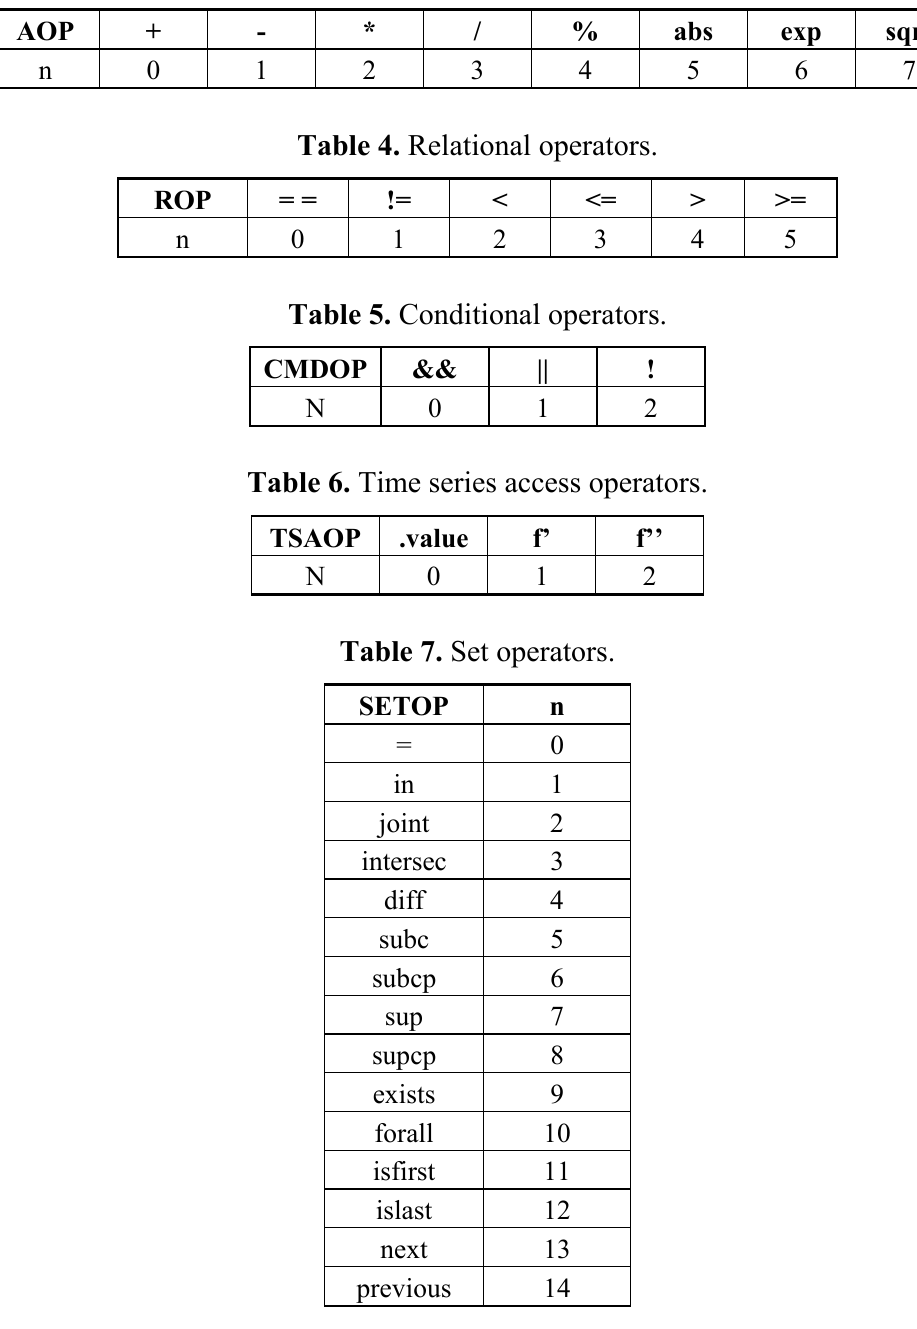
Table 3. Arithmetic operators.